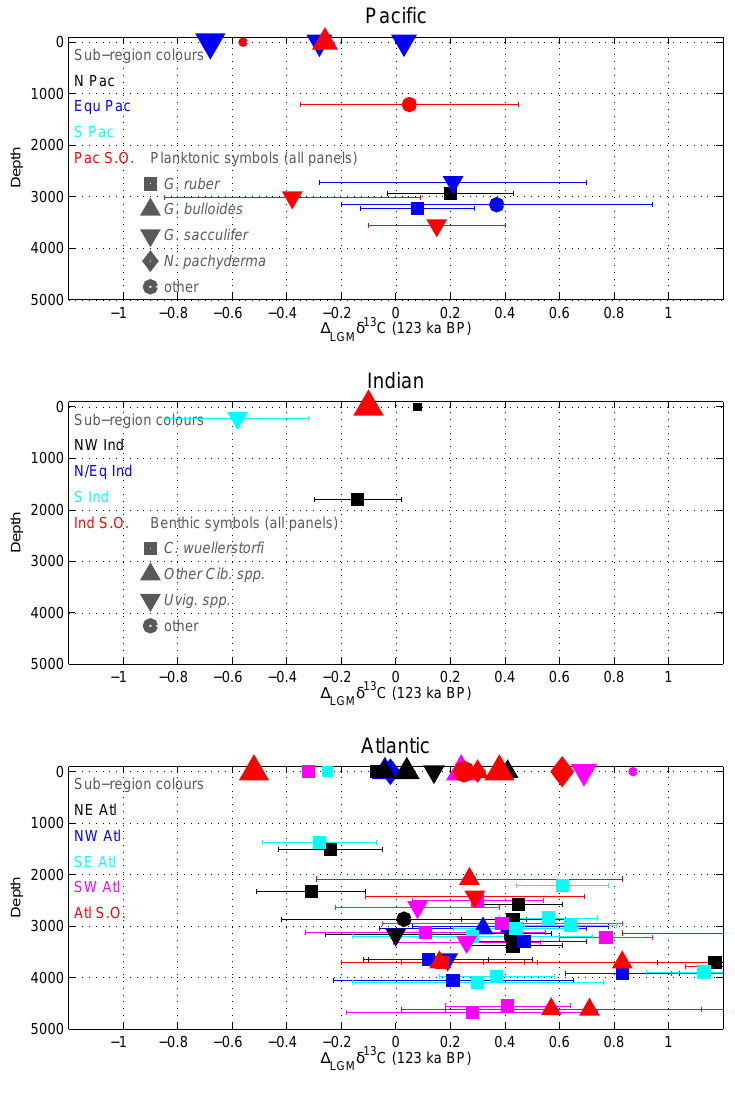
Fig. 14. 123ka 1 LGM δ 13 C time-slice, with 2 σ error bars on benthic data.